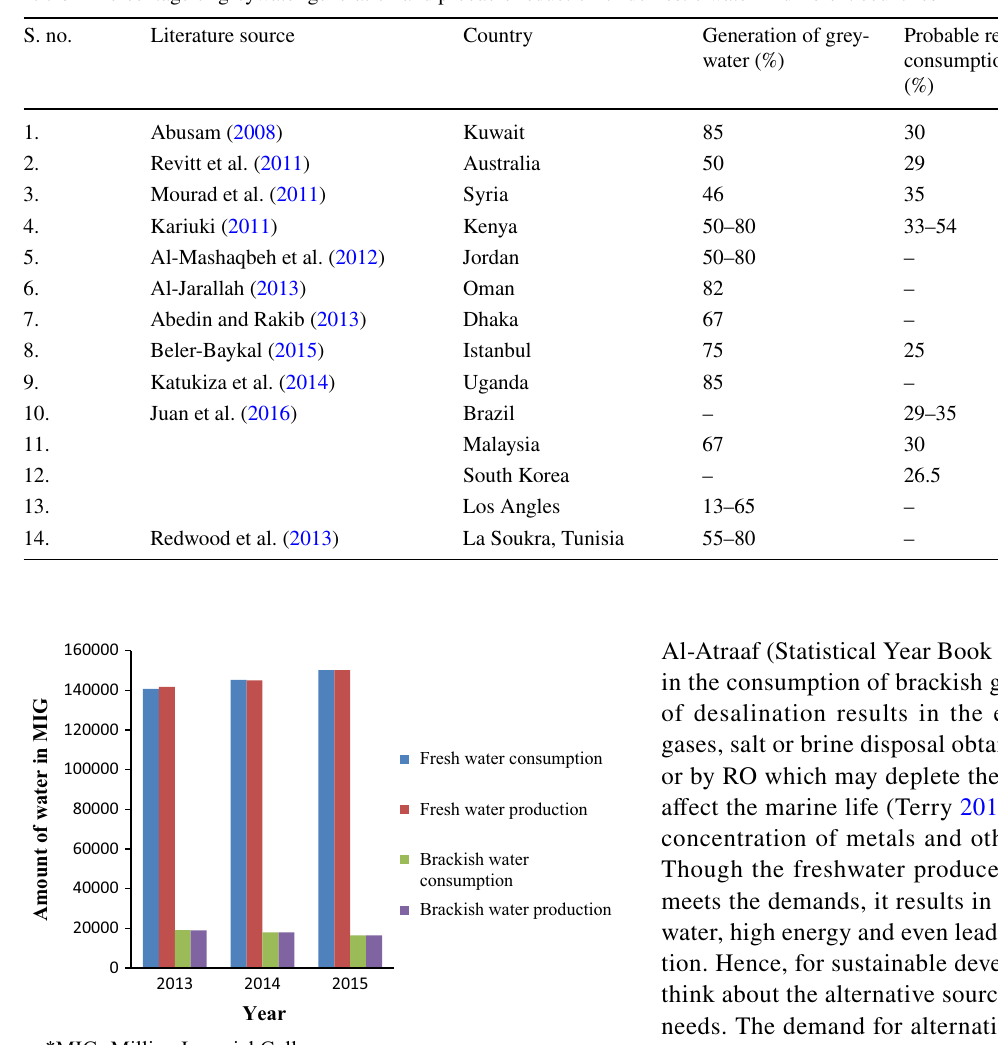
*MIG- Million Imperial Galloon Fig. 1 Statistics on the Consumption and Production of Fresh Water and Brackish Water in Kuwait (Statistical Year Book (Water), Kuwait 2016). * MIG Million Imperial